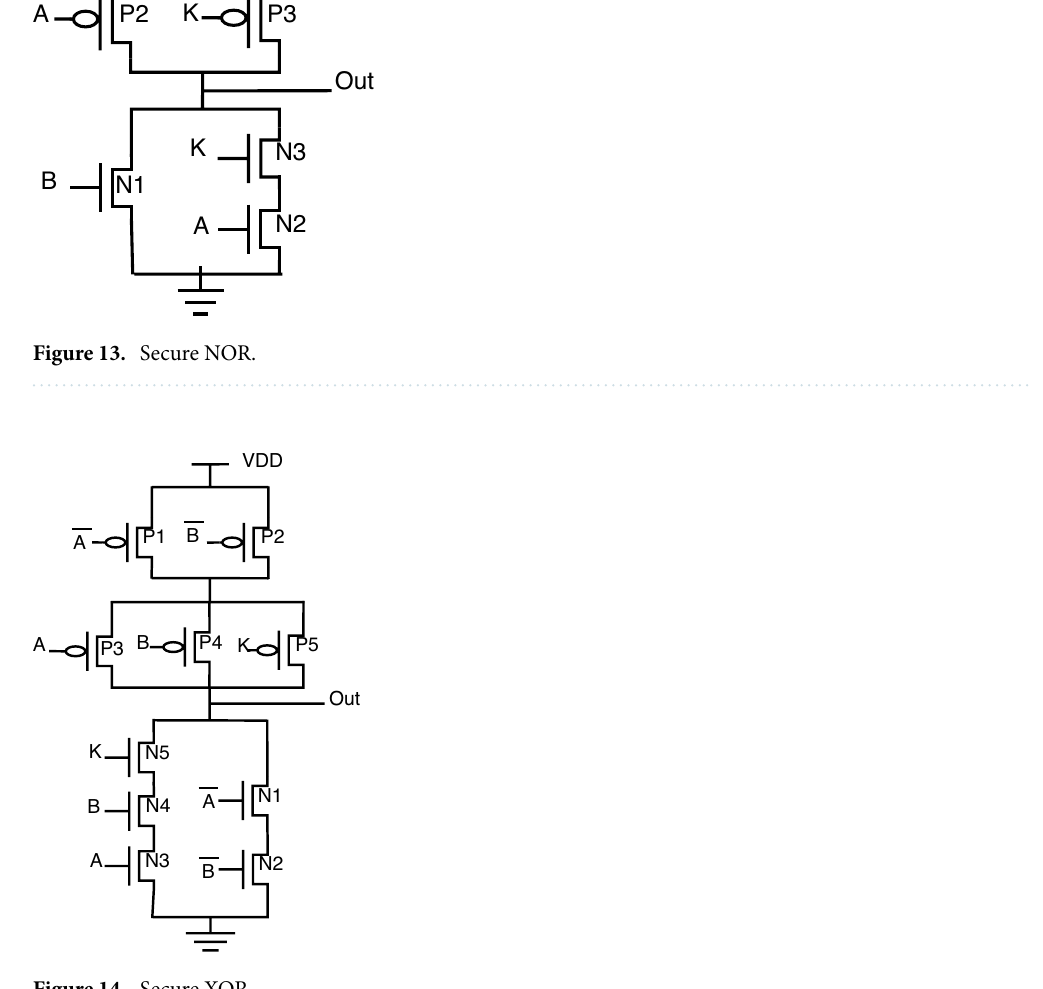
Figure 14. Secure